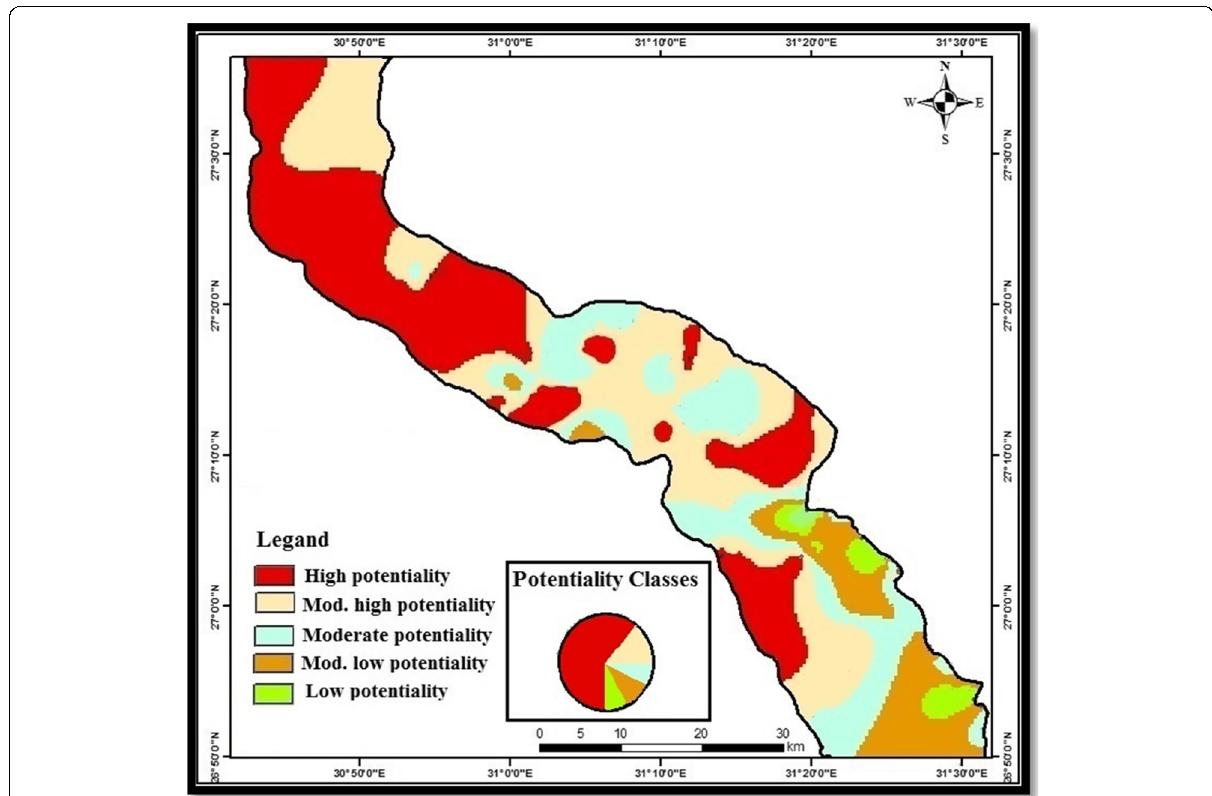
Fig. 17 Groundwater potentiality map of the study area for drinking